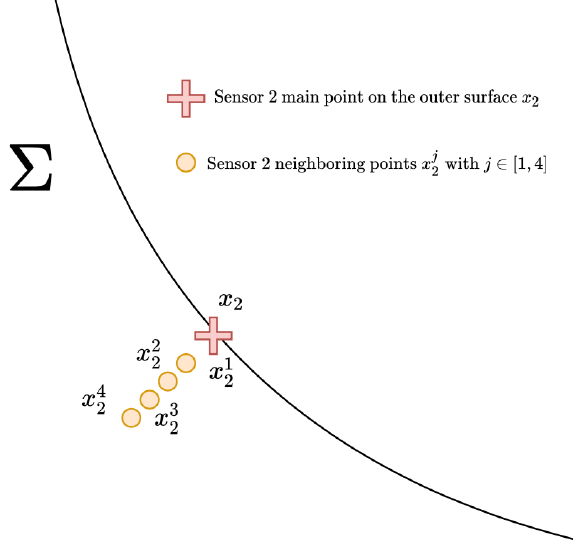
Figure 10. Schematic representation of the sensor 2 ( x 2 ) and the associated measurement points x j the gear Σ